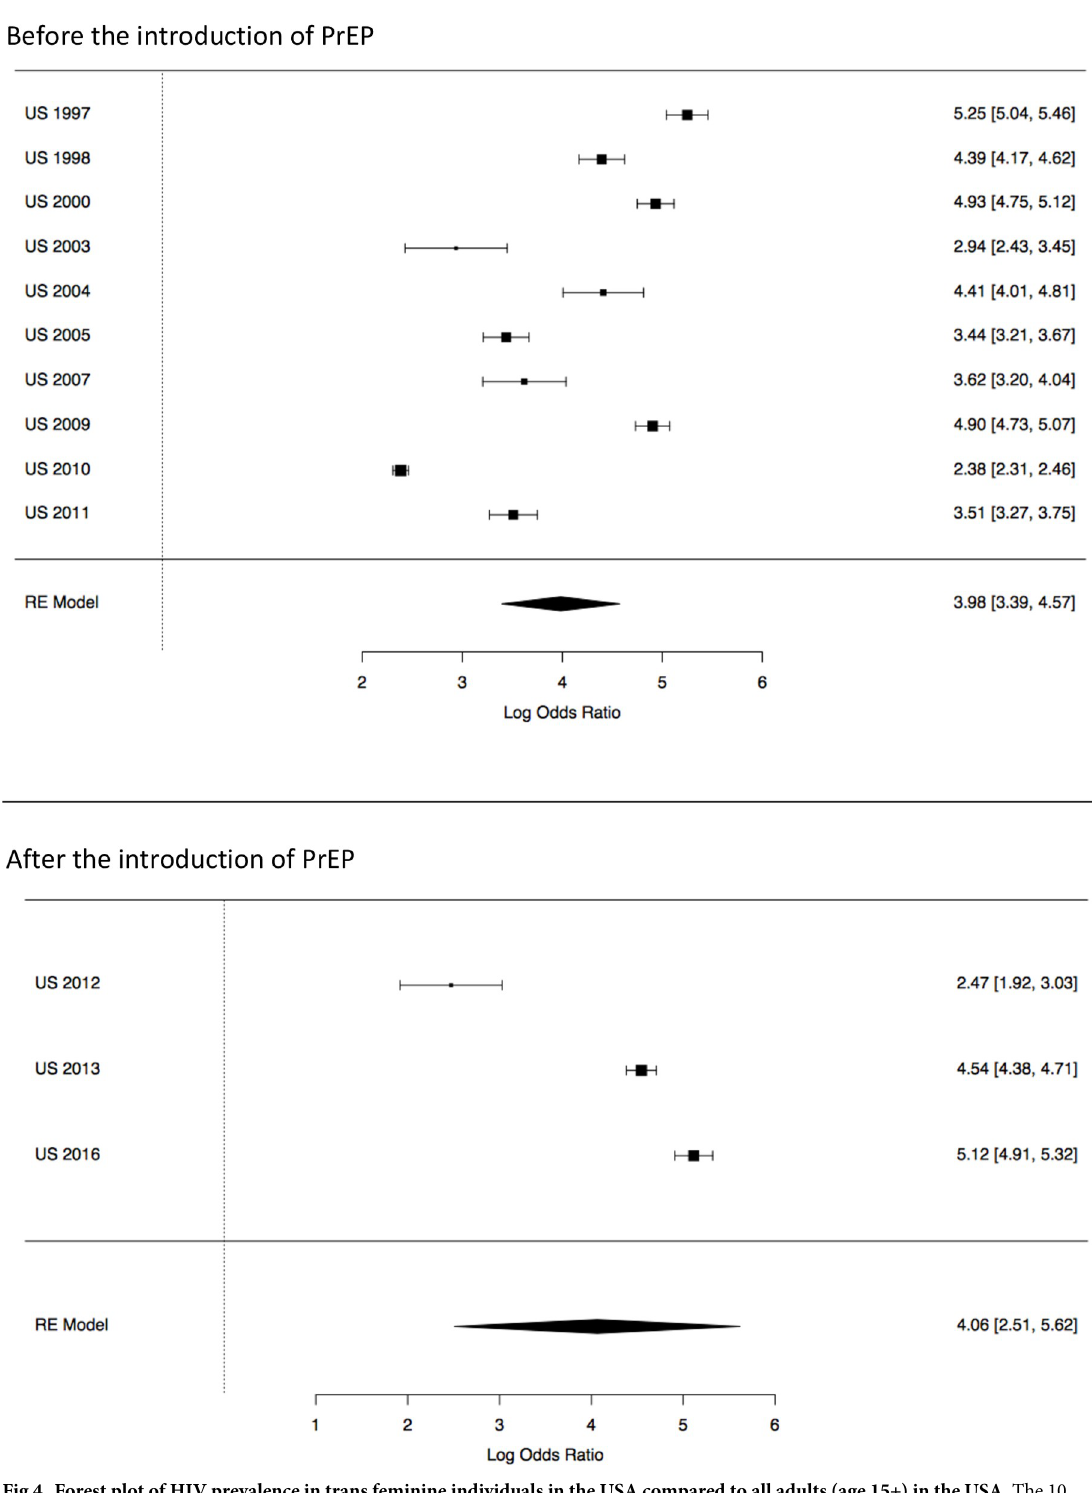
Fig 4. Forest plot of HIV prevalence in trans feminine individuals in the USA compared to all adults (age 15+) in the USA. The 10 country-year including 18 studies above the line are studies where data were collected prior to the introduction of PrEP (2012). The 3 country-year including 6 studies below the line are studies where data were collected after the introduction of PrEP. The scale on the x- axis is log odds ratio. The percentages indicate the weight of each sample within the meta-analysis. The numbers in the right column are the log odds ratios including their confidence